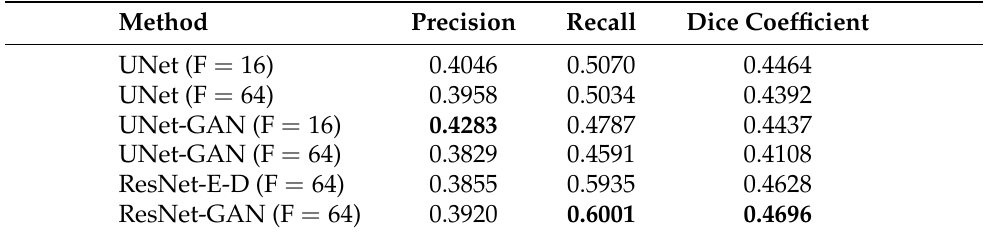
Table 1. Evaluation of pixelwise precision, recall, and the Dice coefficient for chain line segmentation of the validation set with 12 images. Best scores are highlighted in